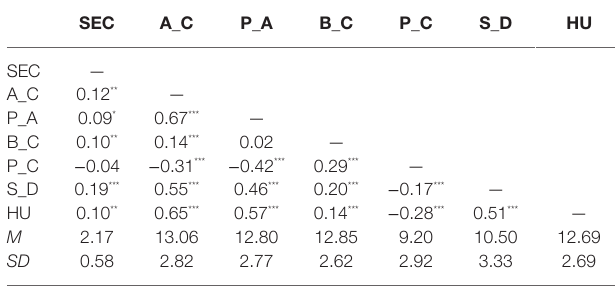
TABLE 1 | Digital creativity and parenting styles. Correlations and descriptive statistics